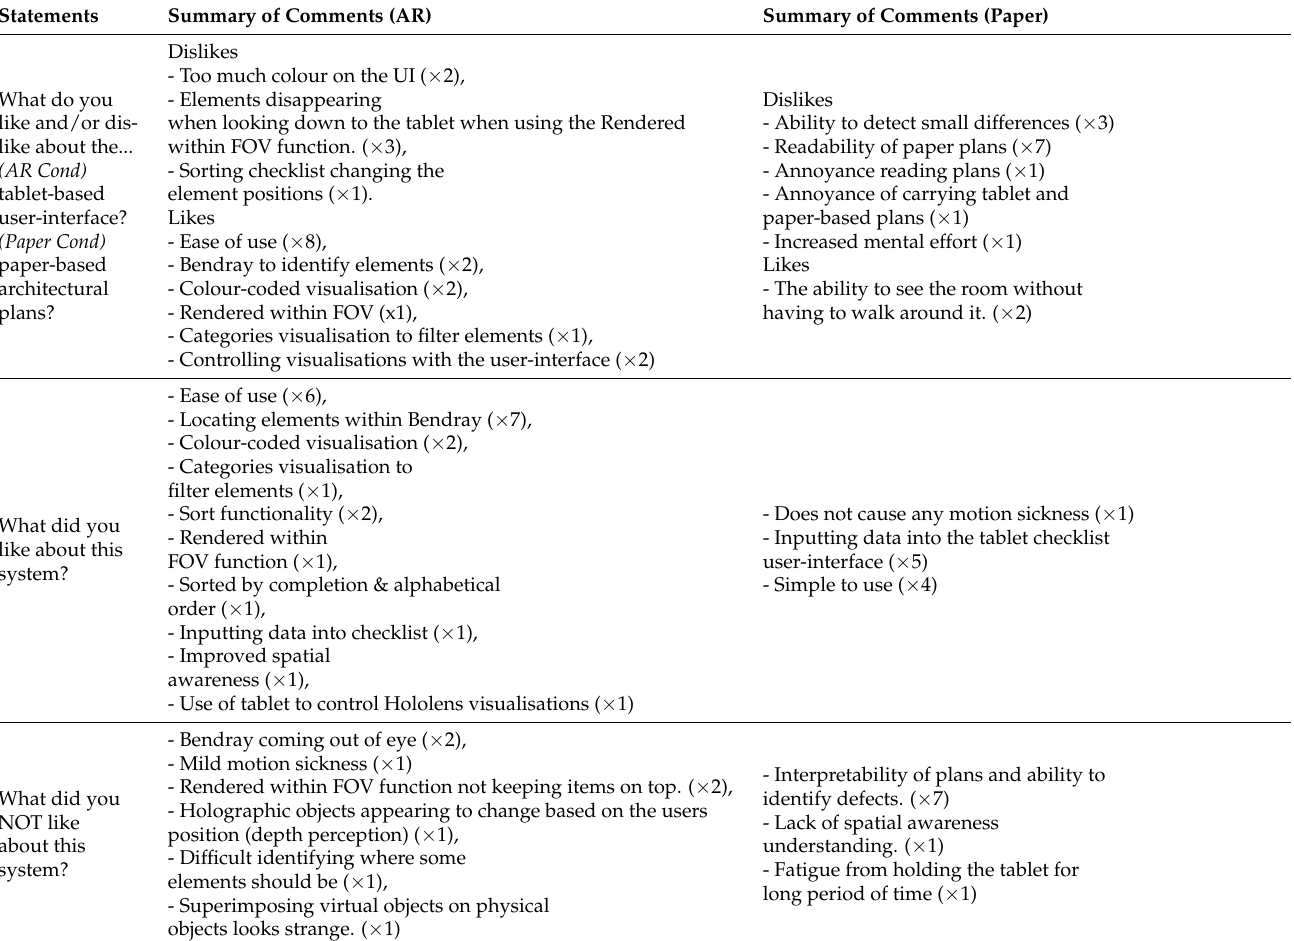
Table 6. This table provides a summary of the subjective open-ended short-answer comments made by participants after completing both